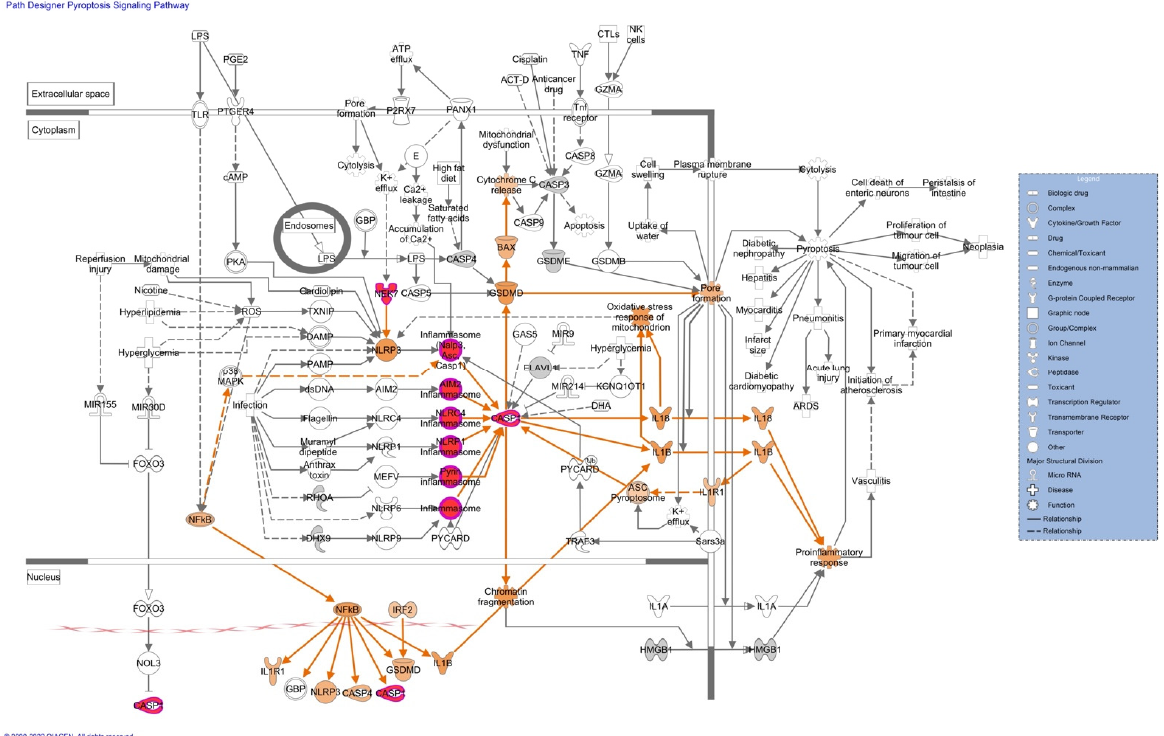
Figure 4. Pyroptosis signaling pathways of differentially expressed proteins from ZIKV-positive and negative placentas. Prediction legend: the intensity of red corresponds to higher upregulation of the protein. These proteins are the caspase-1 (CASP1) inflammasome component and the serine/threonine-protein kinase Nek7 (NEK7). Grey means that the protein was identified but there was no significant increase in expression. Our proteomics experiments did not detect proteins in orange in the diagrams. Orange means predicted activation of the protein or interaction leading to activation. The protein gene name is used in the diagrams. Data were analyzed using of IPA (QIAGEN Inc., https://www.qiagenbioinformatics.com/products/ingenuitypathway-analysis; accessed 15 September 2022).